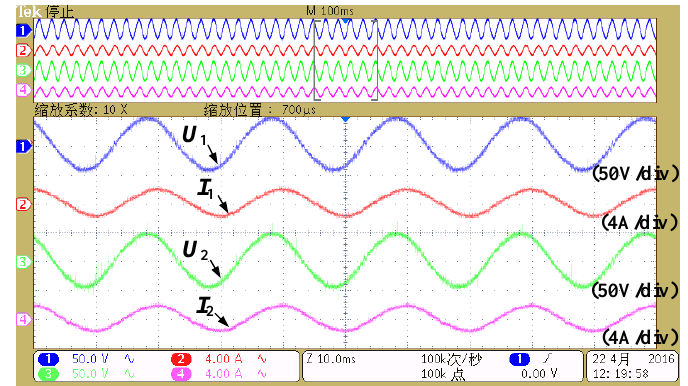
Figure 21. Steady state experimental waveforms of Case III.